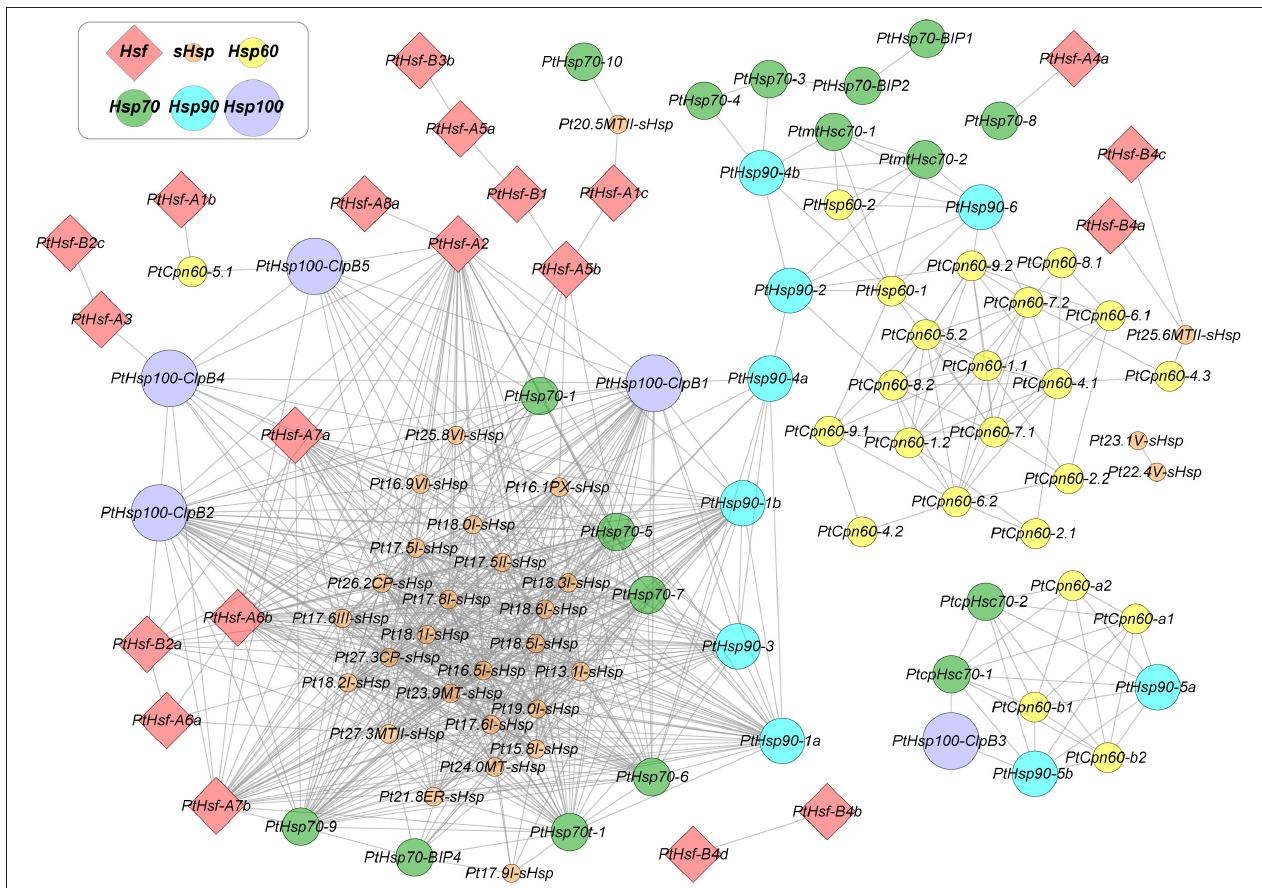
FIGURE 1 | Co-expression network of the HSF and HSP genes in Populus . Nodes represent HSFs and HSPs genes in Populus , and edges indicate pairwise correlation constructed by weighted gene co-expression network analysis (WGCNA). Node color codes represent different gene families. Red diamonds indicate HSFs, and solid circles with orange, yellow, green, cyan, and purple indicate sHSPs , HSP60s , HSP70s , HSP90s , and HSP100s , respectively. Lines represent the co-expression interaction. The network was created using Cytoscape.